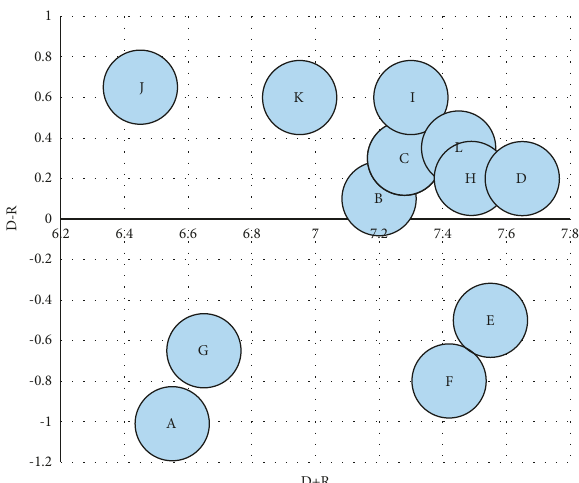
Figure 1: The causal diagram of potential PMO